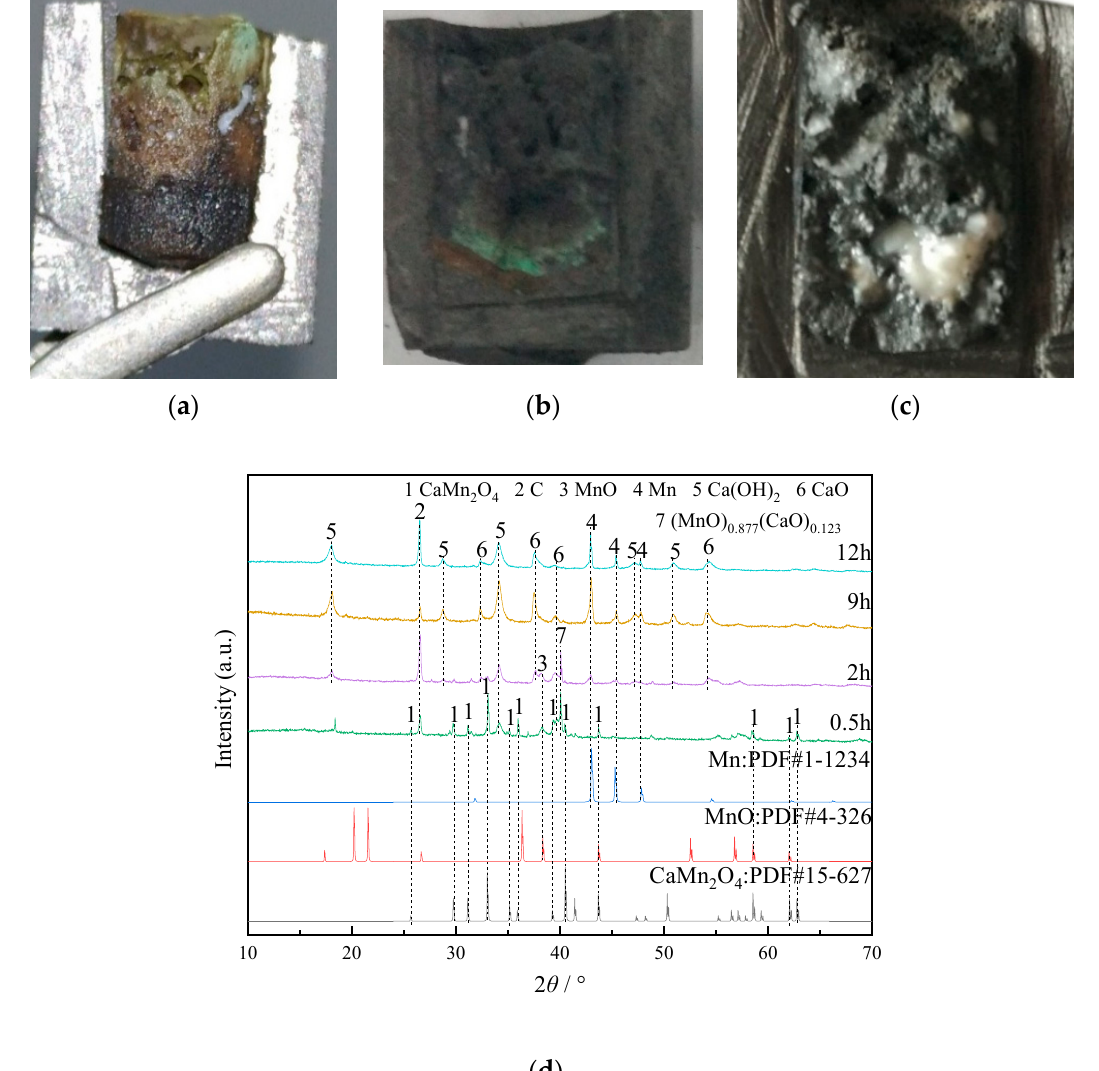
Figure 8. Deoxygenation products of lithium manganate at different times under the condition of 750 °C and 3 V: ( a ) 1 h; ( b ) 6 h; ( c ) 12 h; ( d ) XRD.